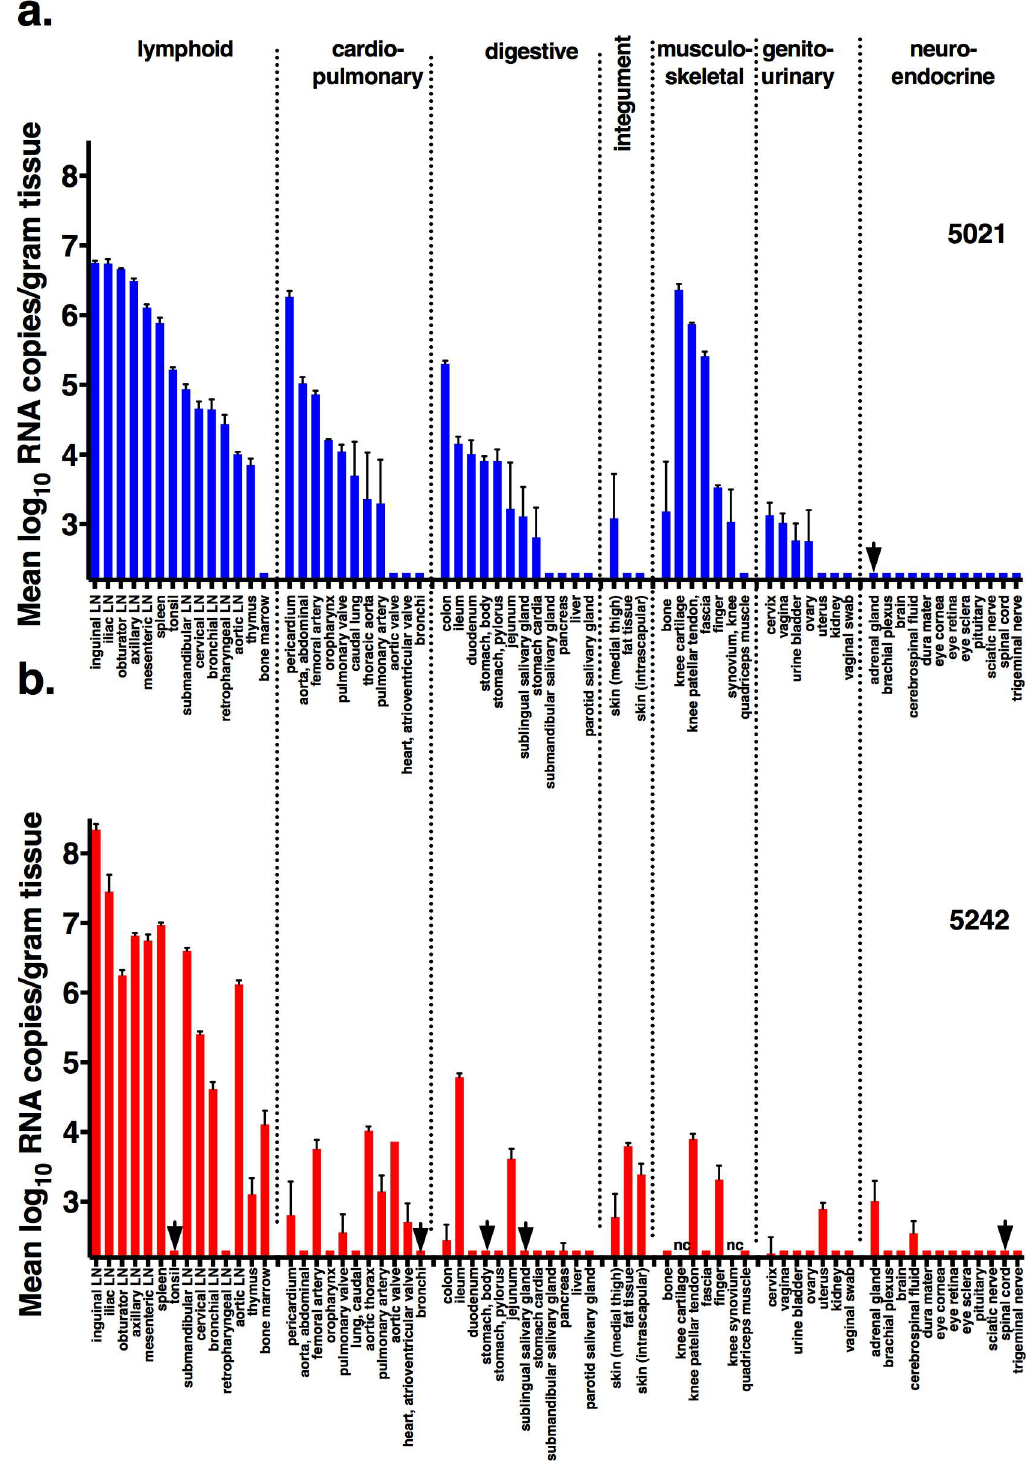
Fig 2. ZIKV tissue distribution in macaques. ZIKV RNA was measuredby qRT-PCR assay in triplicate with standarddeviationsnoted for a) animal 5021 and b) animal 5242. The limit of detectionvaried dependingon the weight of tissue sampledand volume of MEM neededto homogenize to liquefaction,with a mean of 2.3 (range 1.4–4) log 10 RNA copies per gram; non-reactive samples are reportedat 2.0. log 10 RNA copies per gram. Arrows indicate qRT-PCR negativesamples that tested positive by the qualitativeAptima ® assay. nc indicates not